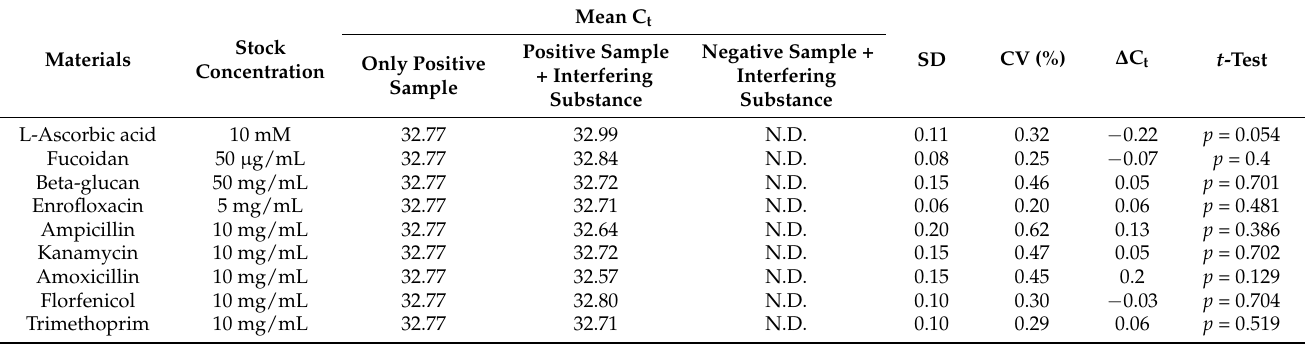
Table 1. TaqMan-based real-time PCR analysis in the presence of nine potential PCR inhibitors. All experiments were performed in triplicate. The ∆ C t value is the difference between the mean C t value (from three replicas) of the RSIV-positive amplicon and that of the RSIV-positive amplicon in the presence of an interfering substance.